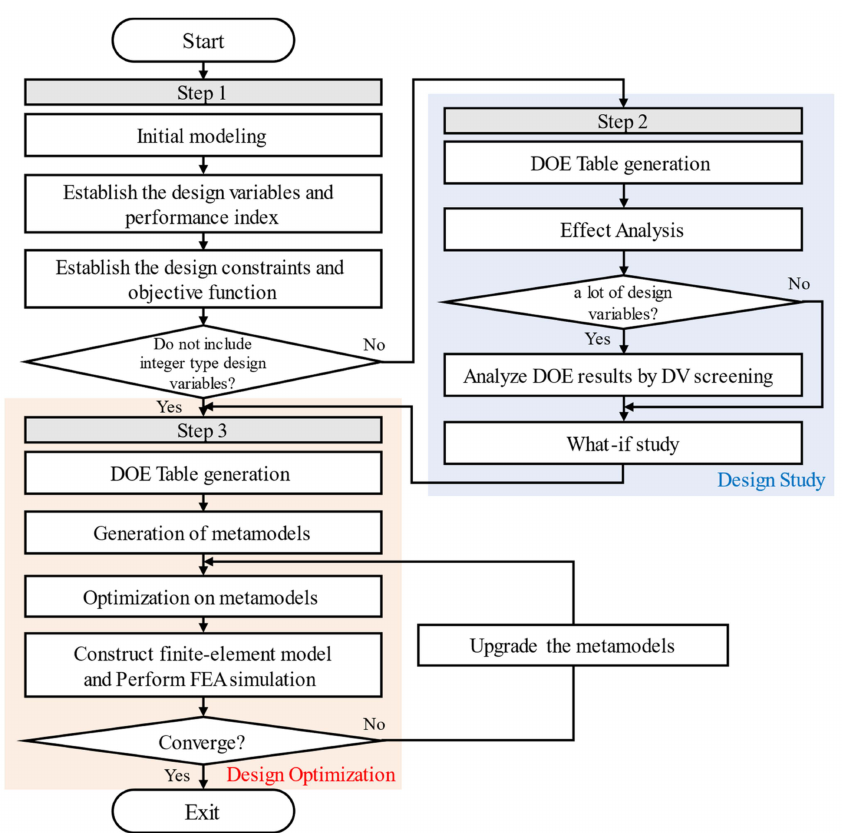
Figure 14. An optimum design process having an integer type design